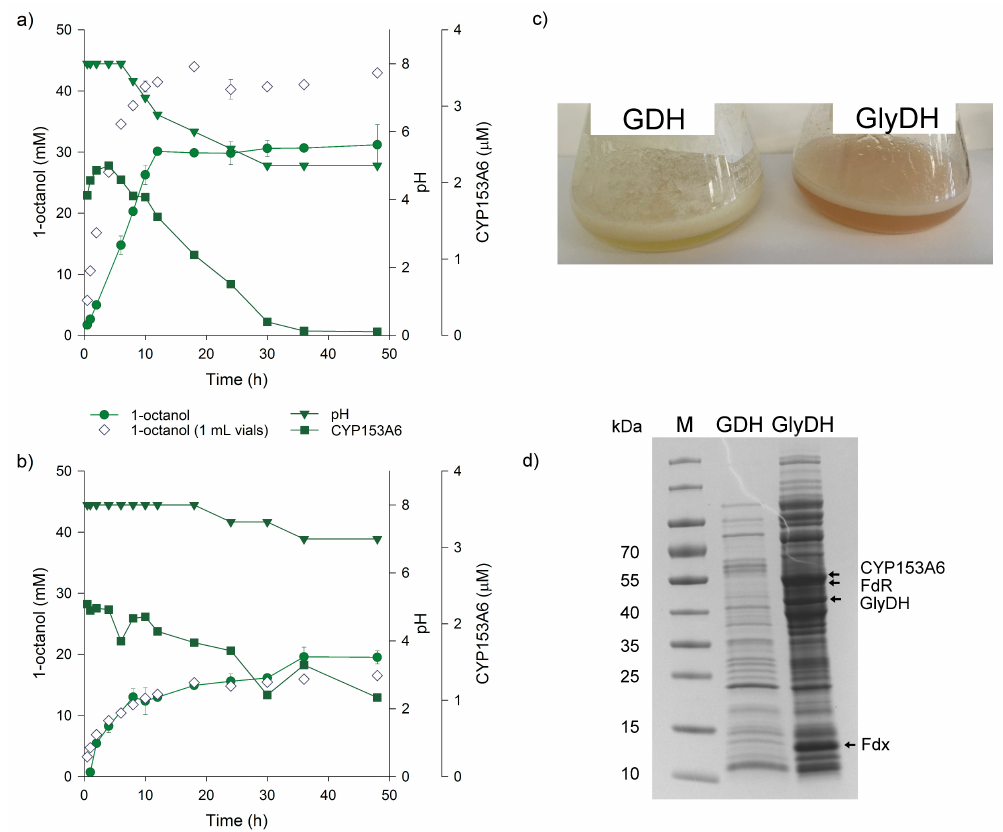
Figure 6. Effect of cofactor regenerating systems based on GDH ( a ) and GlyDH ( b ) on